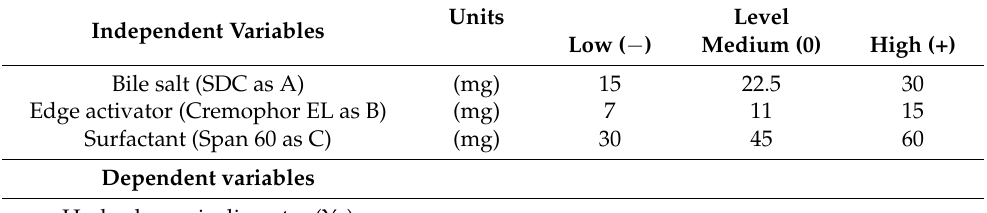
Table 3. Independent and dependent variables used to prepare MX-loaded bilosomes